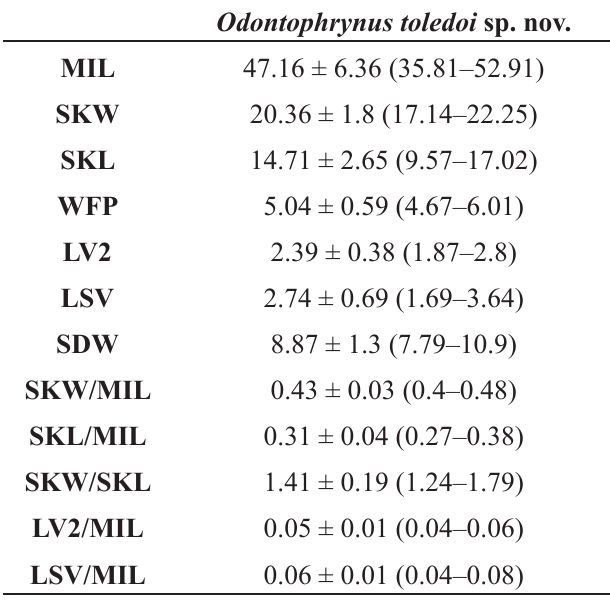
Table 3. Measurements (in mm) and proportions of the holotype and five paratype males of Odontophrynus toledoi sp. nov. Values presented as mean ± sd, minimum–maximum values (range). See Material and methods for abbreviation definitions.